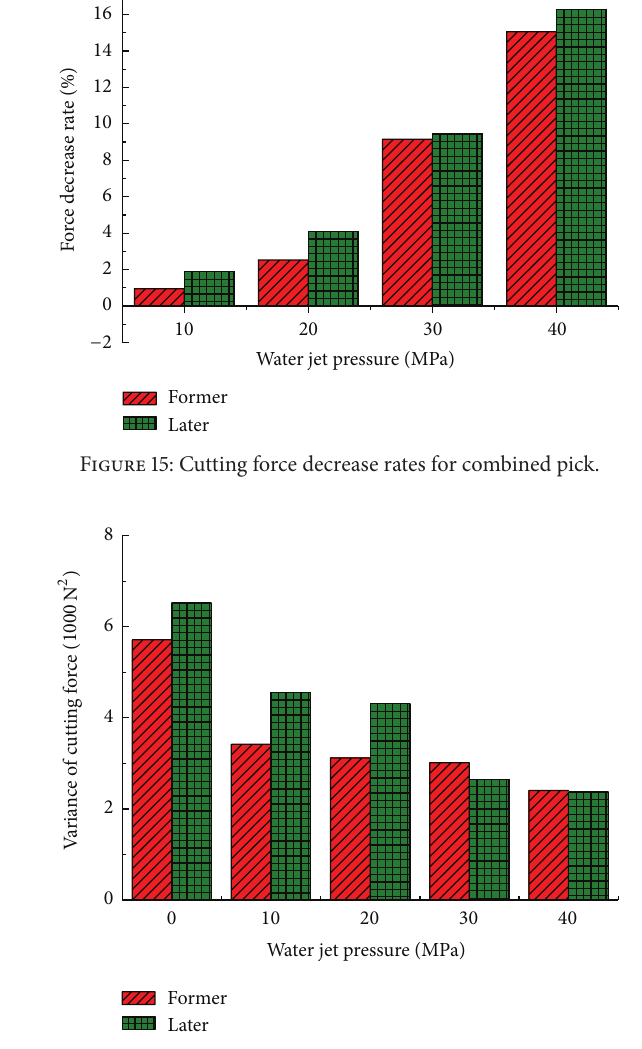
Figure 16: Variance of the cutting force for combined